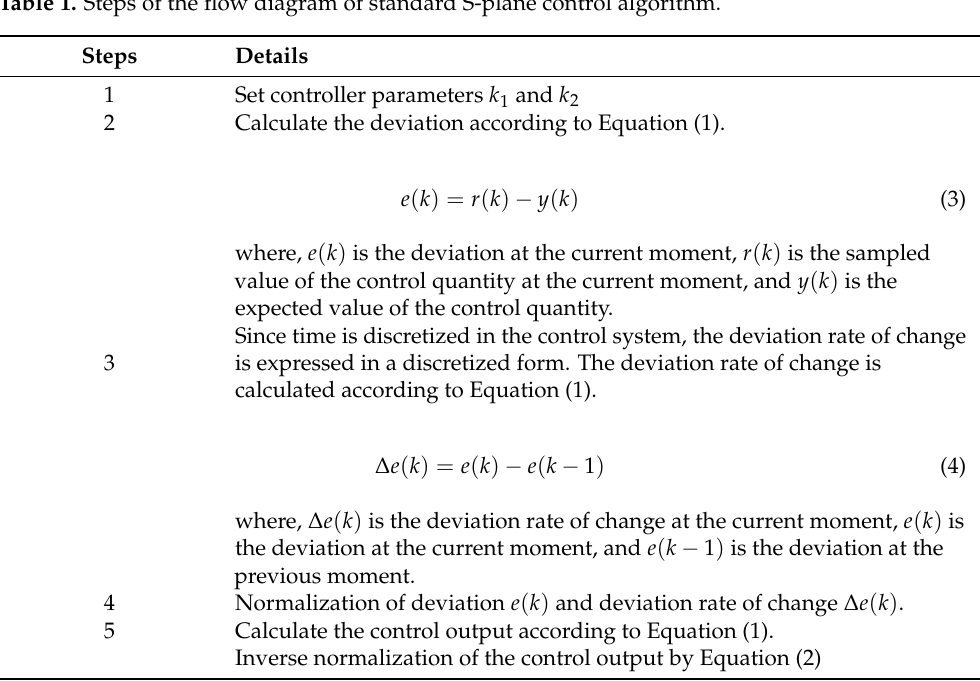
Table 1. Steps of the flow diagram of standard S-plane control